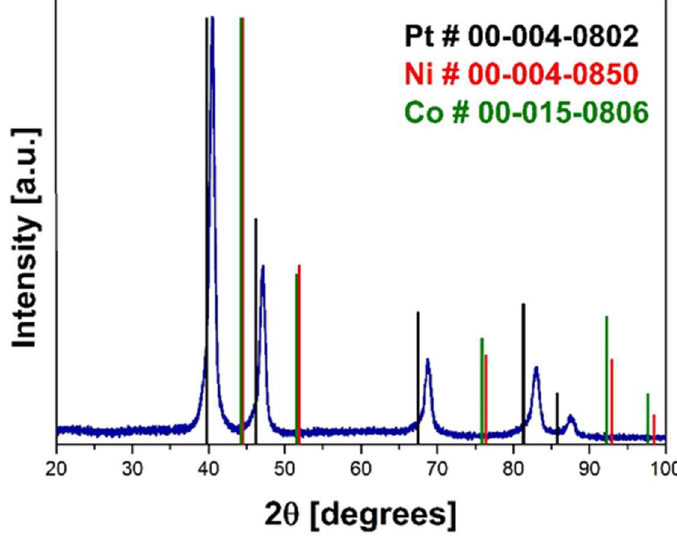
Figure 1. Powder di ff raction pattern of the Pt 2 NiCo / C Figure 1. Powder diffraction pattern of the Pt 2 NiCo/C nanocatalyst.